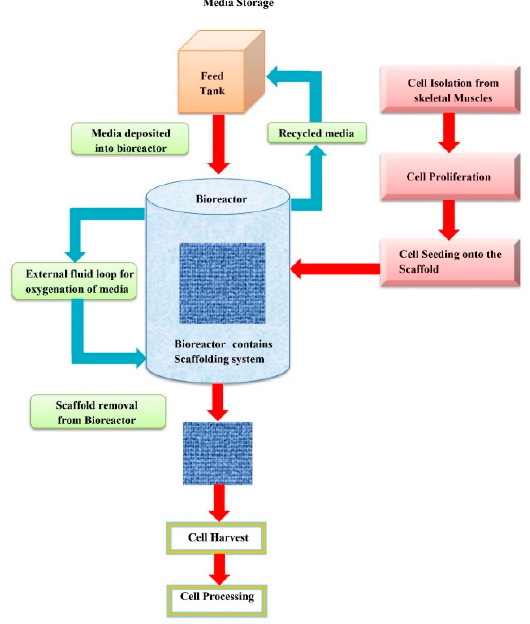
Figure 3. A schematic representation of cultured meat production.